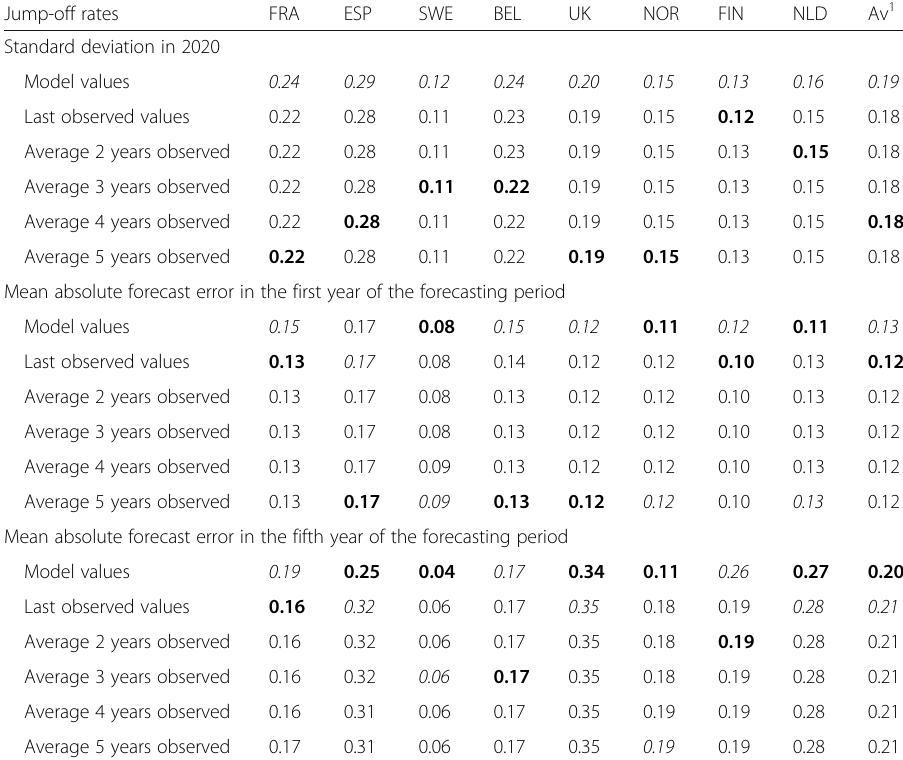
Table 6 Mean absolute forecast error (MAFE) of remaining life expectancy at age 65 for the first and fifth year in the forecasting period and standard deviation (SD) of the increase/decrease of the life expectancy at age 65 in 2020 between ten successive forecasts, for six different choices of the jump-off rates applied to the Cairns-Black-Dowd method (ages 65 to 95), for eight Western European countries, men and women combined, fitting periods 1960 – 2005, 1960 – 2006, … , 1960 –